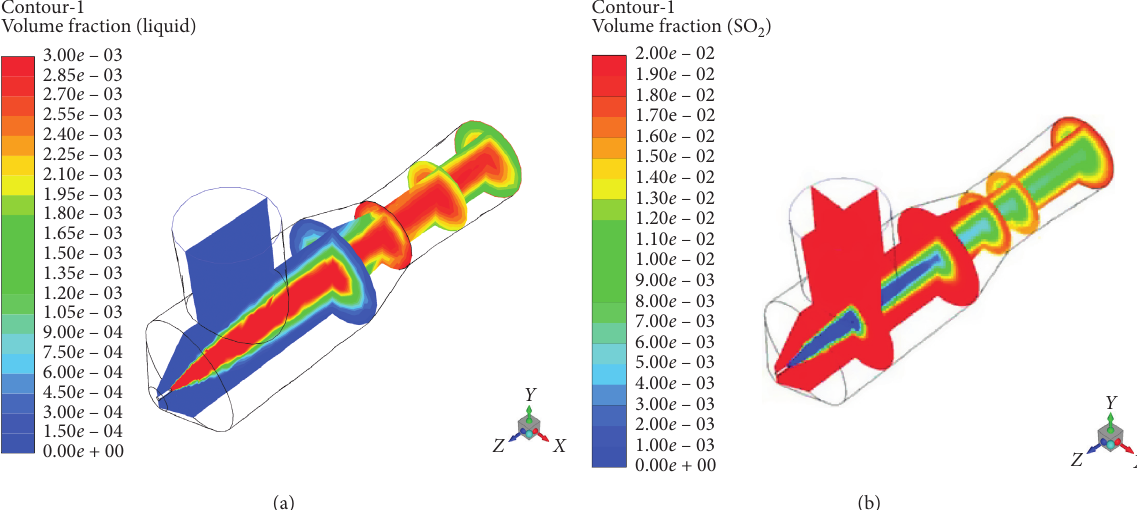
Figure 6: (a) concentration of liquid in venturi; (b) concentration of SO